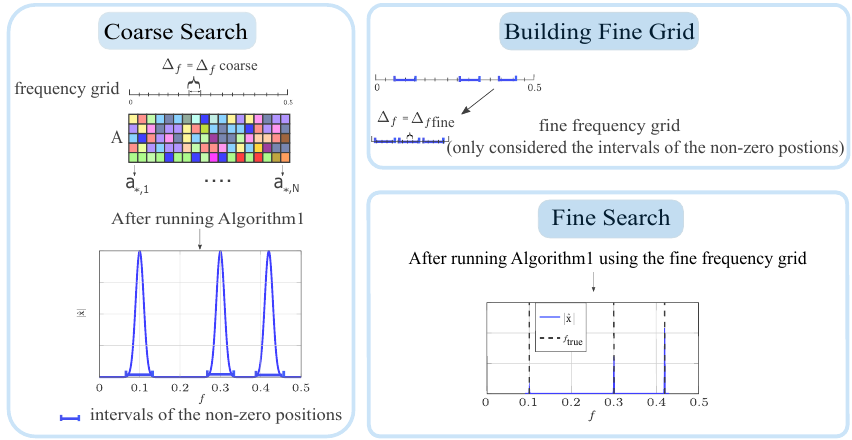
Figure 2. Overall description of the principal steps of the Adaptive-SCCD algorithm. Algorithm 4